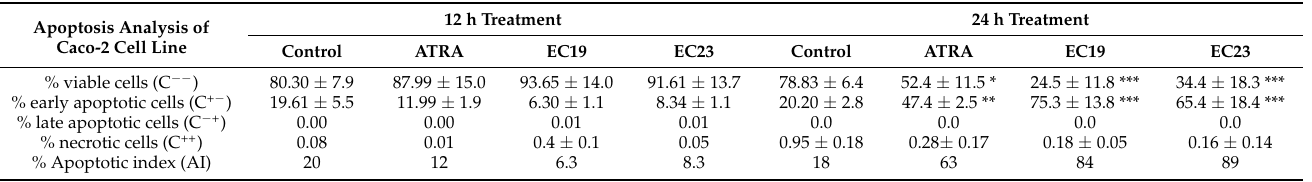
Table 3. The percentage of viable, apoptotic, late apoptotic, and necrotic cells was measured by AV/PI assay using flow cytometry. The assay was performed after the treatment of Caco-2 cells for 12 or 24 h with ATRA, EC19 and EC23 compared to 0.1% DMSO negative control. The apoptotic index was calculated as the percentage of the apoptotic cells to the total number of gated cells. Data represent mean ± standard error of the mean (SEM), n = 3. Apoptosis Analysis of Caco-2 Cell